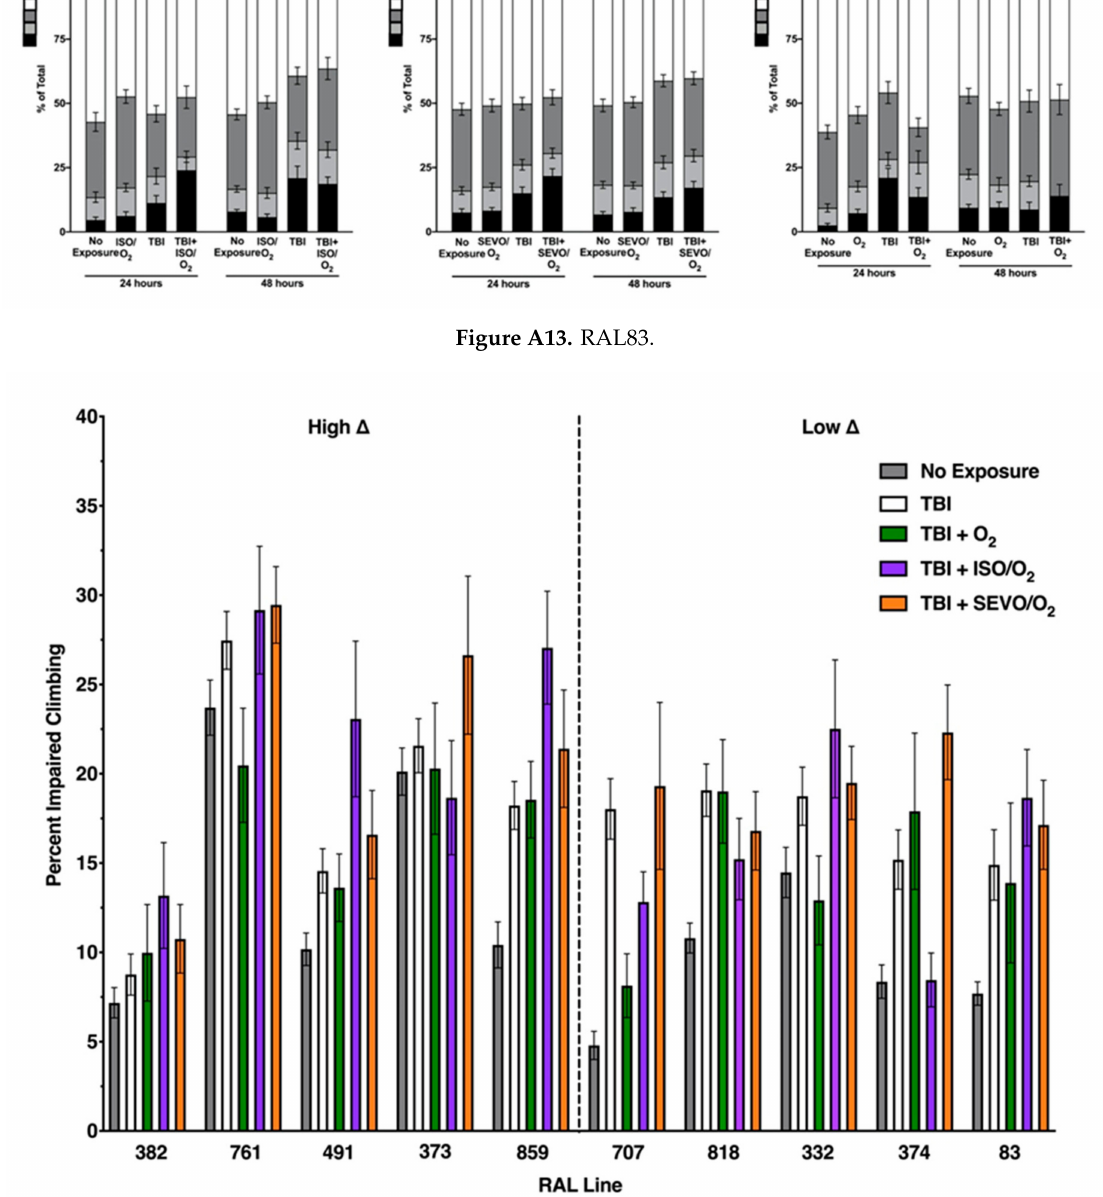
Figure A14. Forty-eight h climbing graph. See Figure 5 for